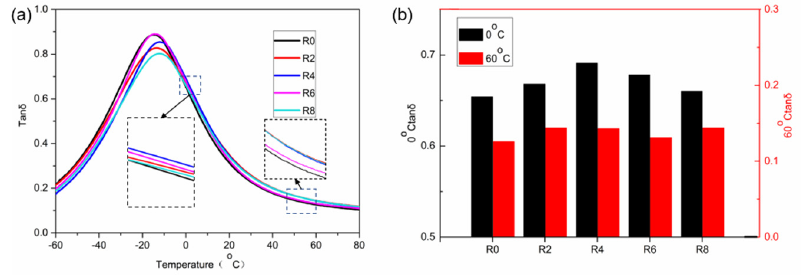
Figure 4. Stress strain curves ( a ), tan δ values at 0 ◦ C and 60 ◦ C ( b ) of the vulcanizates.